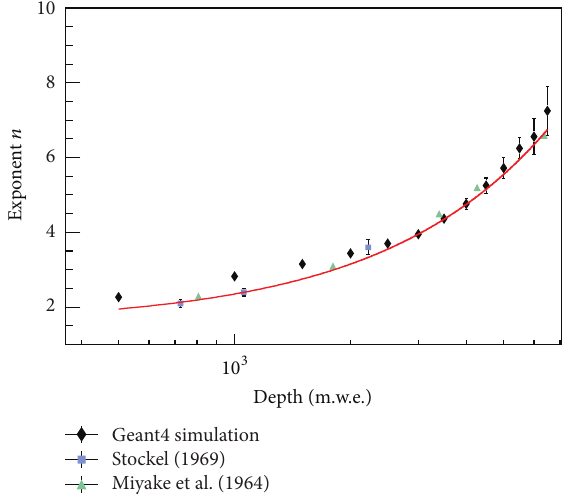
Figure 4: The simulated and experimental exponent 𝑛 as a function of depth in standard rock (color